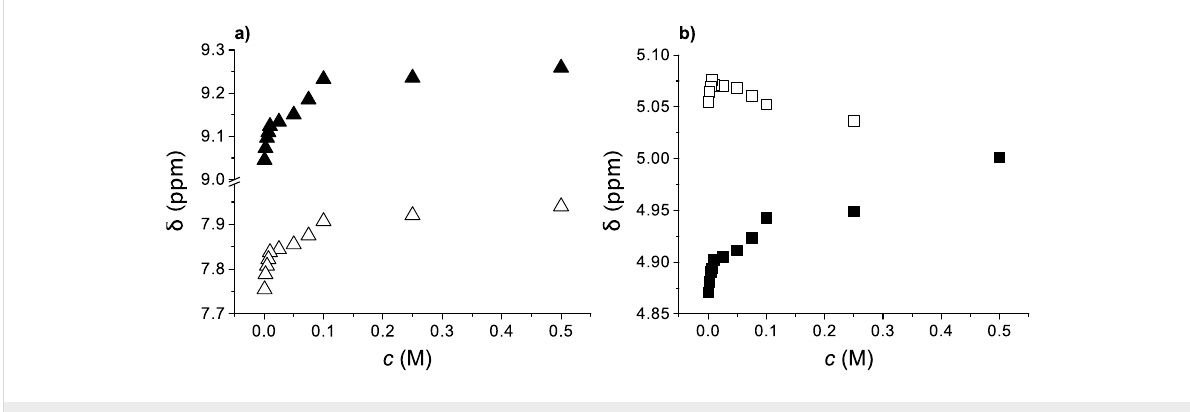
Figure 5: The concentration dependence of NH and C*H chemical shifts in ( S,R )- 1b toluene- d 8 gel samples (concentration range 0.001–0.1 M): a) oxalamide-NH protons ( ▲ ); Leu-NH’s ( Δ ) and b) oxalamide- α -Leu-C*H ( ■ ) and oxalamide- β -Leu-C*H ( □ ) protons.